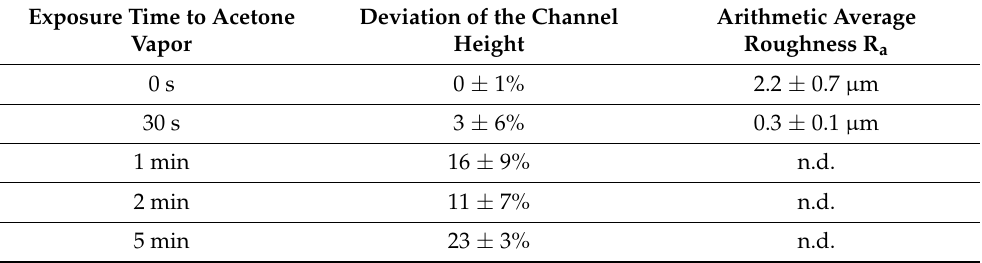
Table 1. Deviation of the channel height from target height and arithmetic average roughness R a for different acetone vapor exposure times. n.d., not detectable.